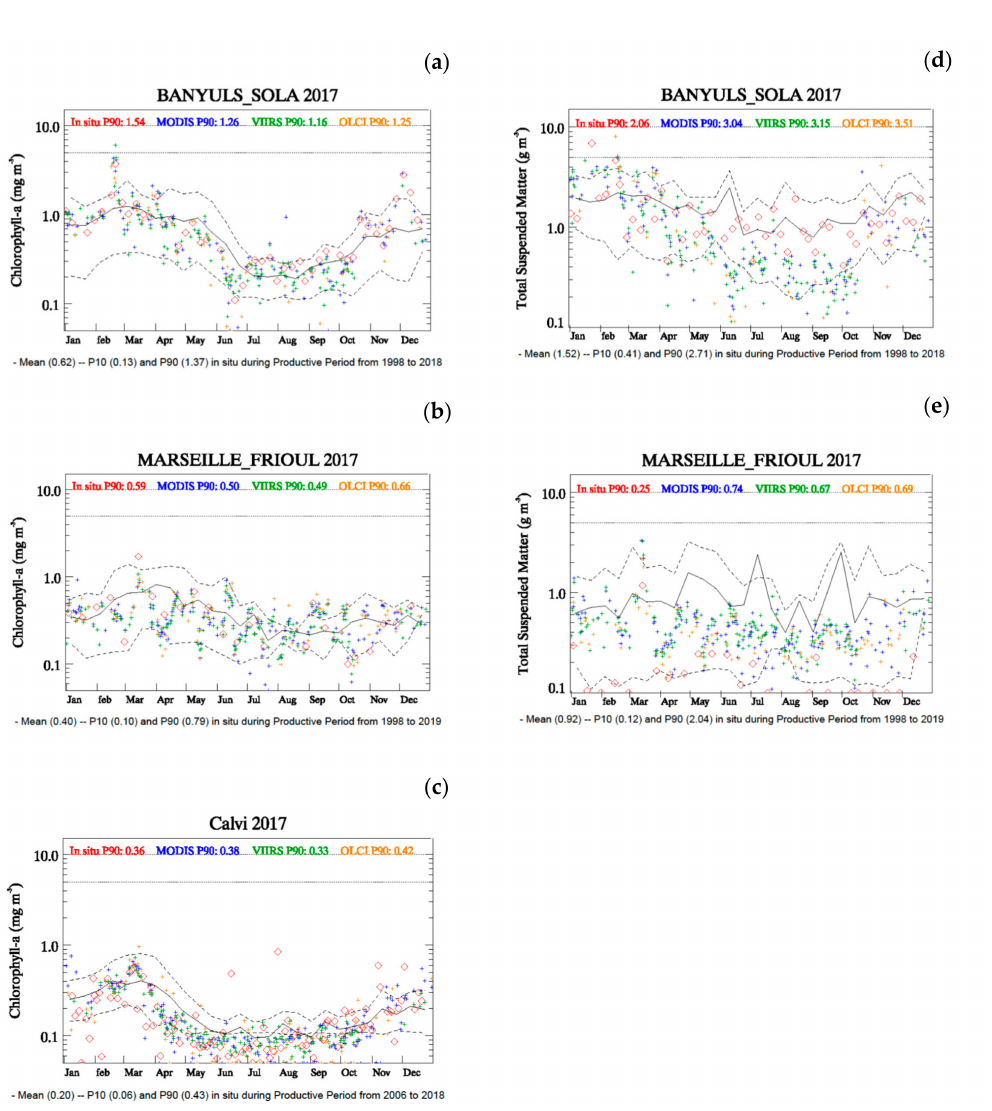
Figure 10. Chl- a ( a – c ) and TSM ( d , e ) in the Mediterranean Sea. In situ and satellite percentiles of year 2017 are indicated in the upper part of the graphs; the in situ historical mean, P10 and P90, calculated over the productive period, are indicated under the time axis.